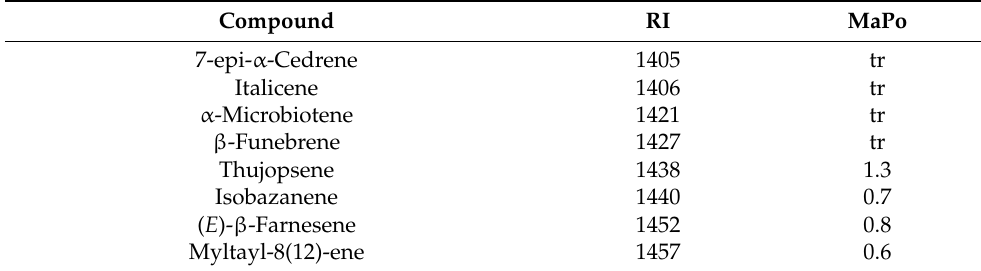
Table 1. The list of the compounds identified in the diethyl ether extract obtained from the thalli